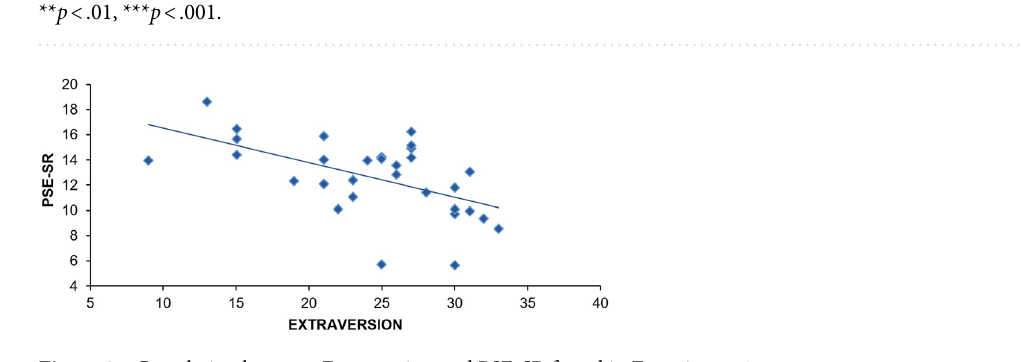
Figure 3. Correlation between Extraversion and PSE-SR found in Experiment